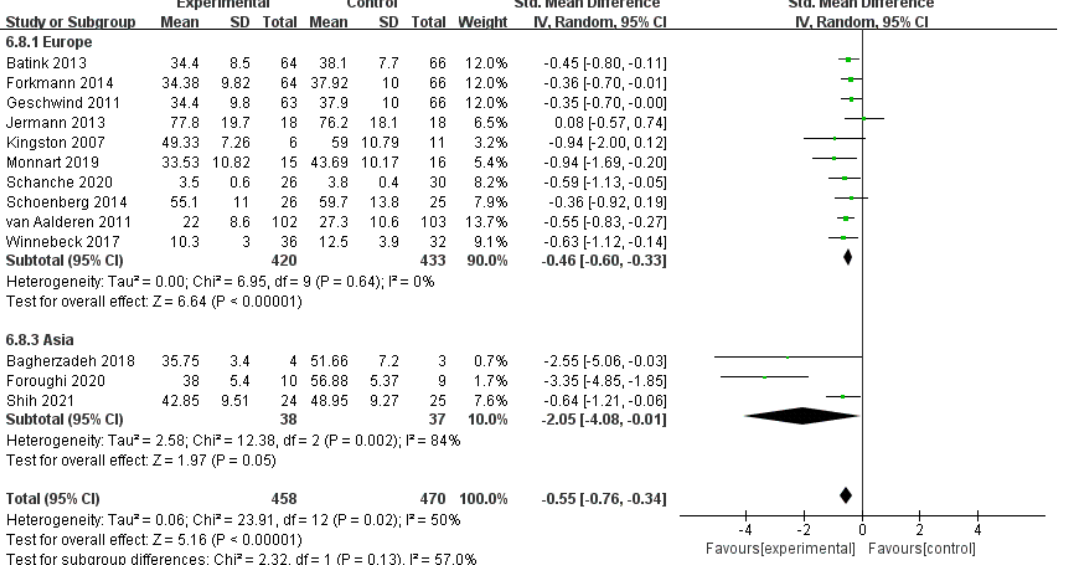
Figure 4. Meta − analyses of the effects of MBIs on rumination between Europe and Asia [30–32,36– 38,40–44,46,48].